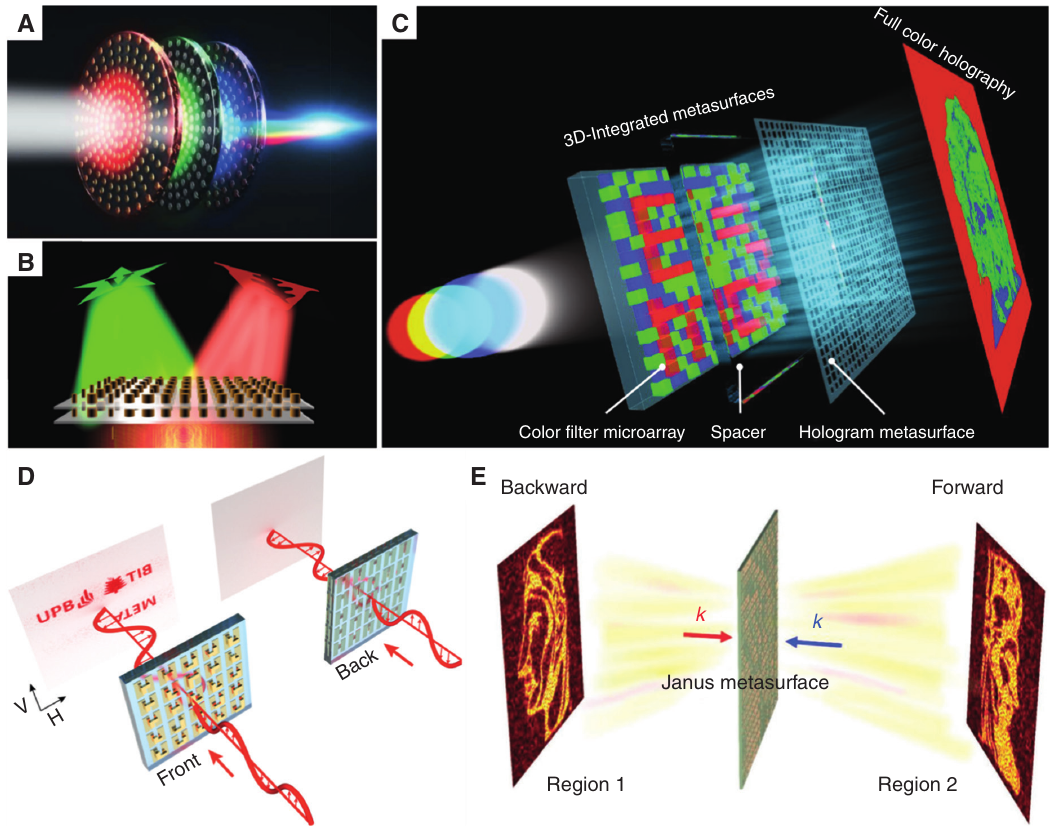
Figure 20: Stacked metasurfaces. (A) Achromatic lens for red, green, and blue light [145]. (B and C) Multichannel image displays [147, 148]. (D and E) Nonreciprocal image displays [149, 150]. Reprint permission obtained from [145,